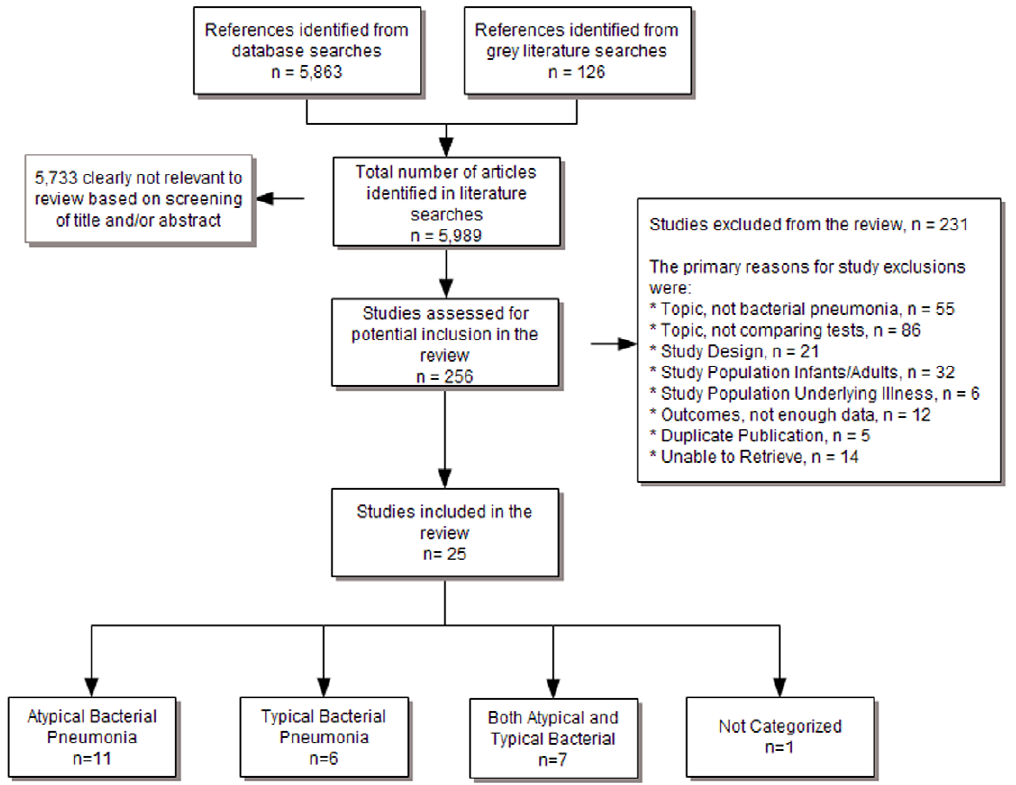
Figure 1. PRISMA flowchart of study selection, retrieval, and inclusion.